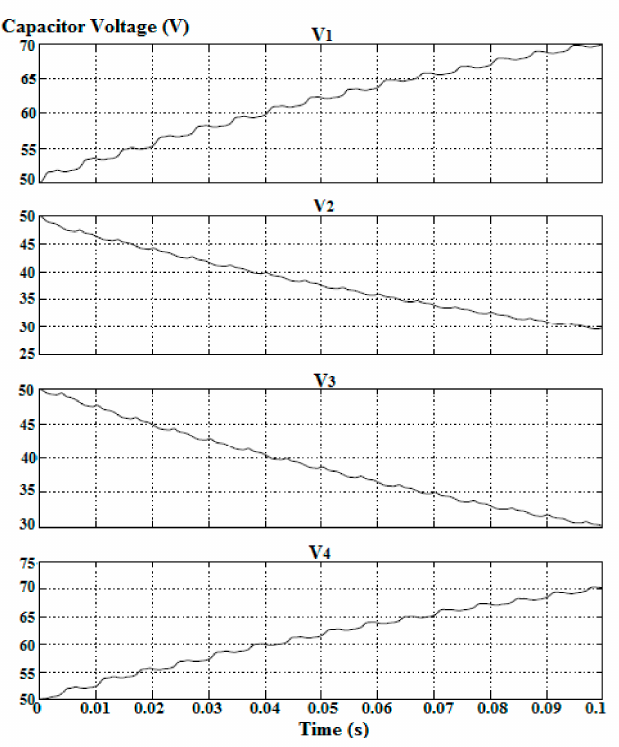
Figure 2. Unbalanced capacitor voltages in a five-level switch-sharing-based multilevel inverter when no voltage balancing control in